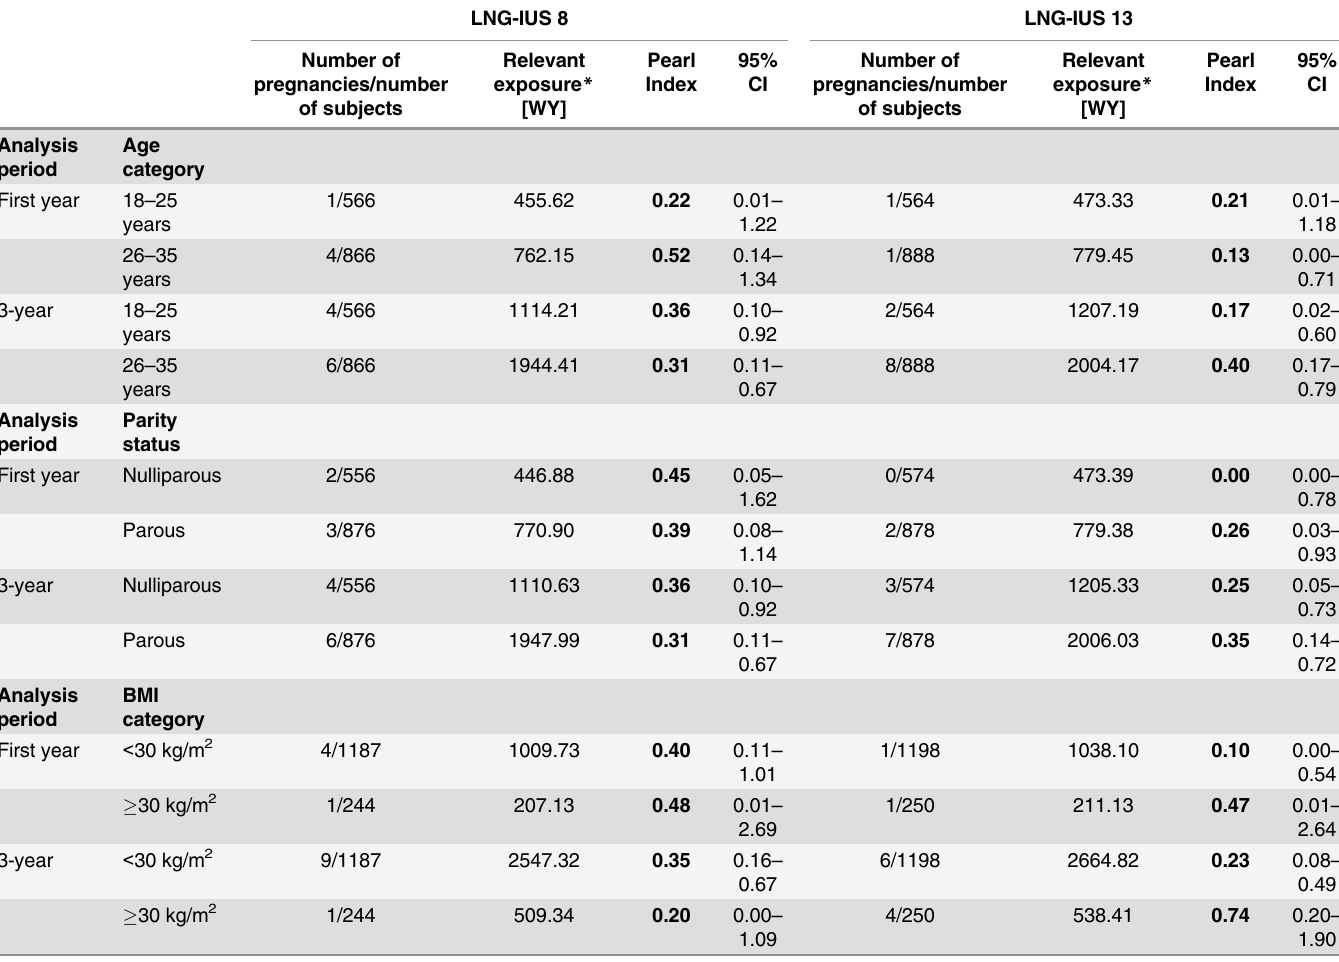
Table 2. Unadjusted First-year and 3-year Pearl Indices According to Age, Parity Status and BMI (Full Analysis